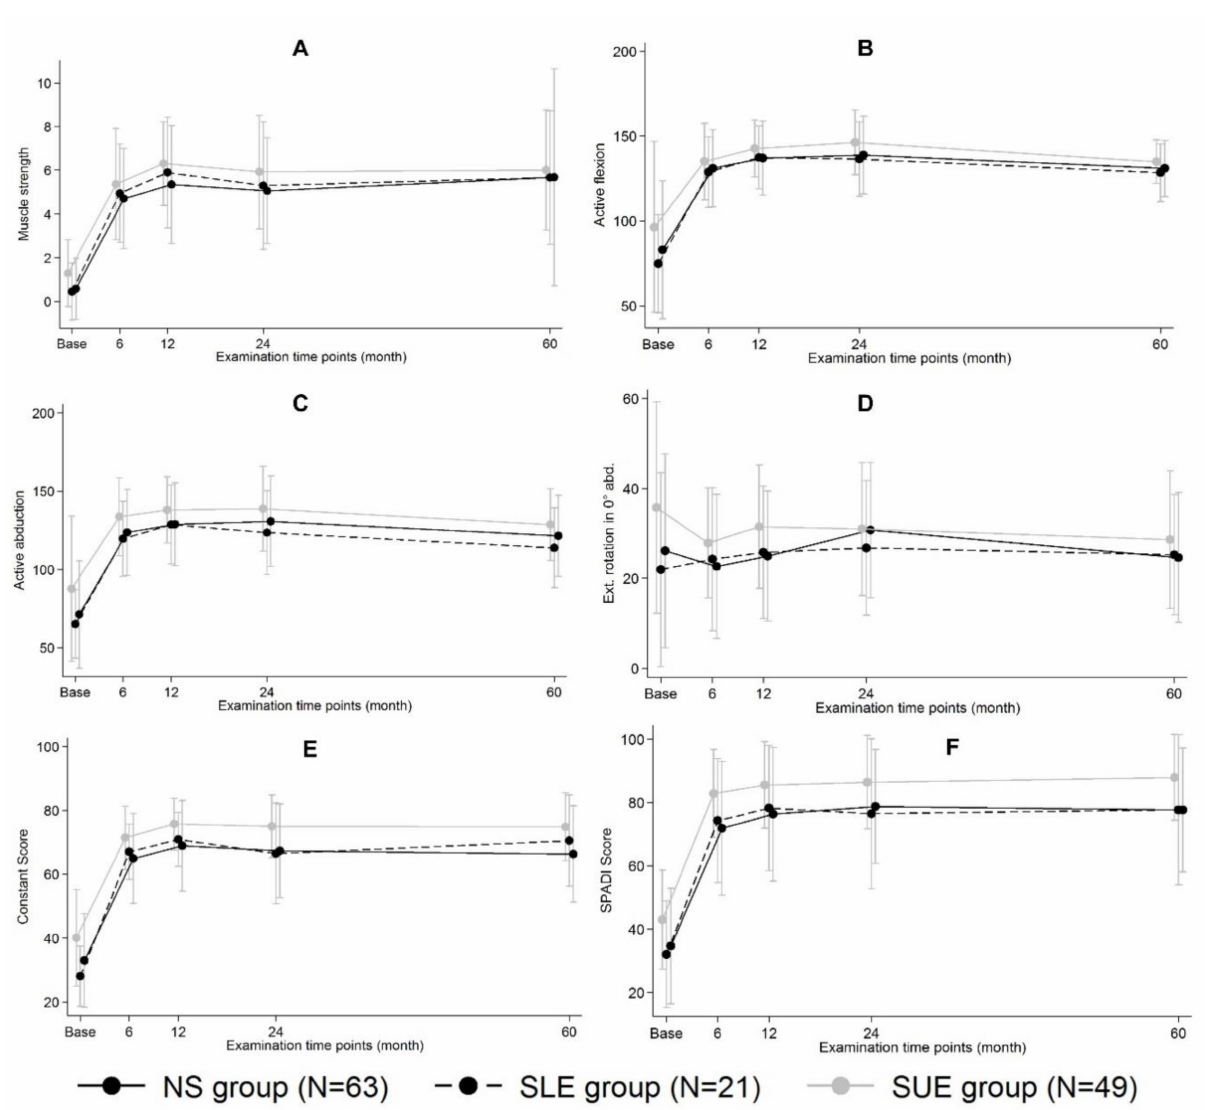
Figure 3. Development of clinical outcomes (( A ) muscle strength; ( B ) active flexion; ( C ) active abduction; ( D ) external rota- tion in 0 ◦ abduction; ( E ) Constant Score; ( F ) SPADI Score) from baseline to 6, 12, 24, and 60 months after RSA